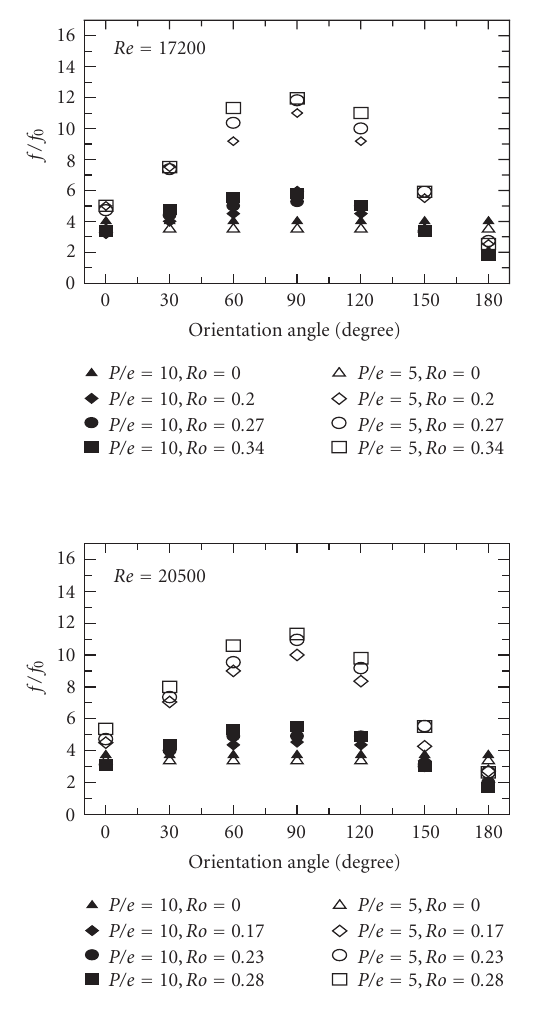
Figure 5: E ff ect of orientation angle in a rib-roughened square channel with attached ribs on one wall (for comparison from Sardeshpande et al. [14]).